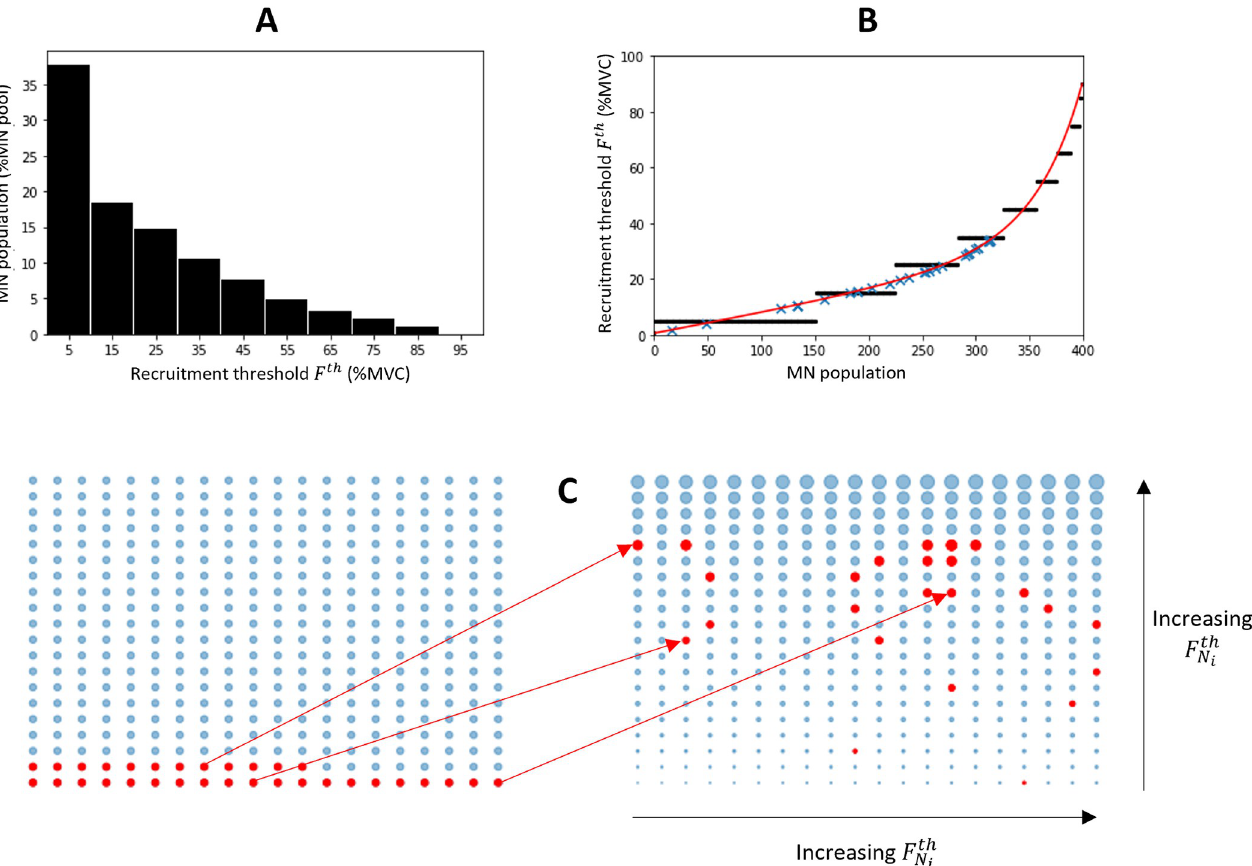
Fig 5. Distribution of force recruitment thresholds F th in the human Tibialis Anterior (TA) muscle and mapping of the N r identified MNs to the complete MN pool. (A) Typical partition obtained from the literature of the TA MN pool in 10% increments in normalized F th . (B) Equivalent F th stepwise distribution (black dots) in a TA pool of N = 400 MNs, approximated by the continuous relationship F th (j) (red curve). The mapping (blue crosses) of the N r = 32 MNs identified in the dataset DTA 35 was obtained from the recorded F th (Fig 4B). (C) N r = 32 MNs (red dots) of unknown properties (Left) are mapped (Right) to the i complete MN pool from the F th (j) distribution, represented by the blue dots of increasing sizes. The MNs represented here are numbered from left to right and bottom to top from j = 1 to 400 .